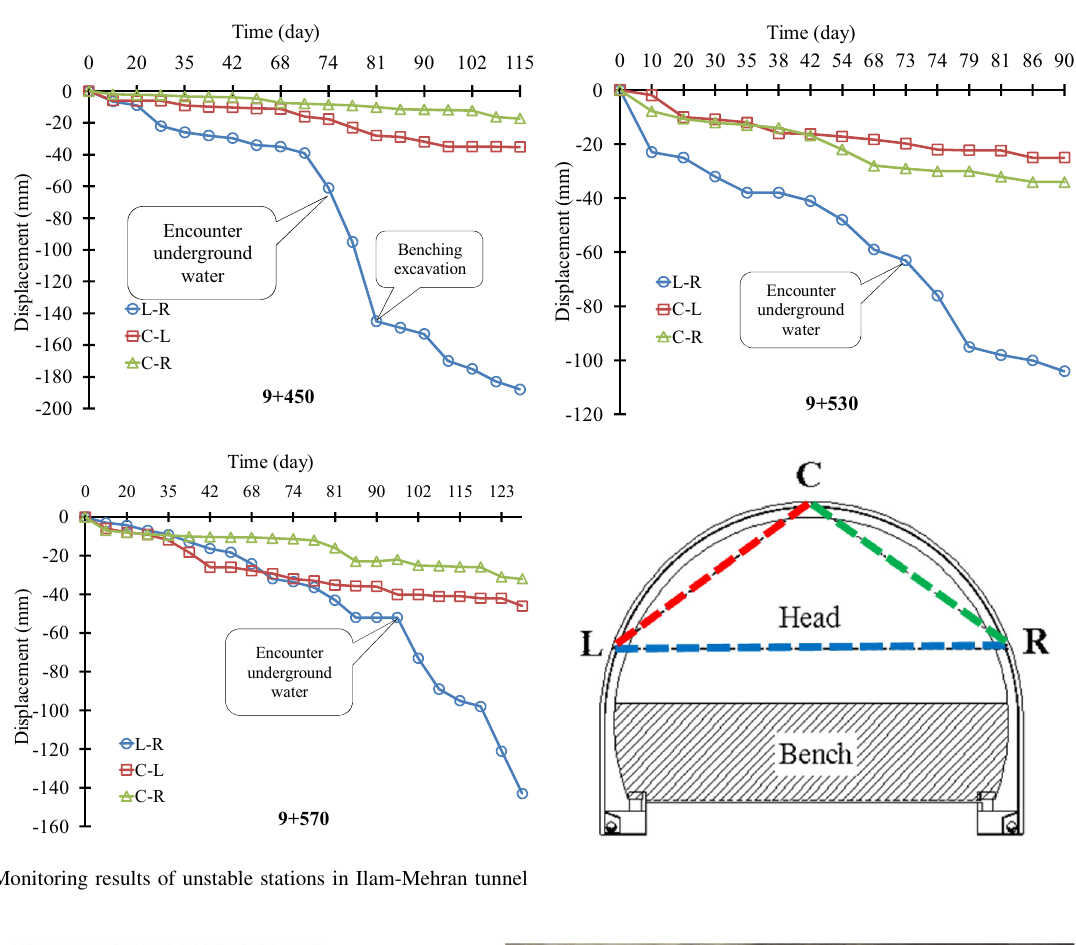
Fig. 8 Monitoring results of unstable stations in Ilam-Mehran tunnel